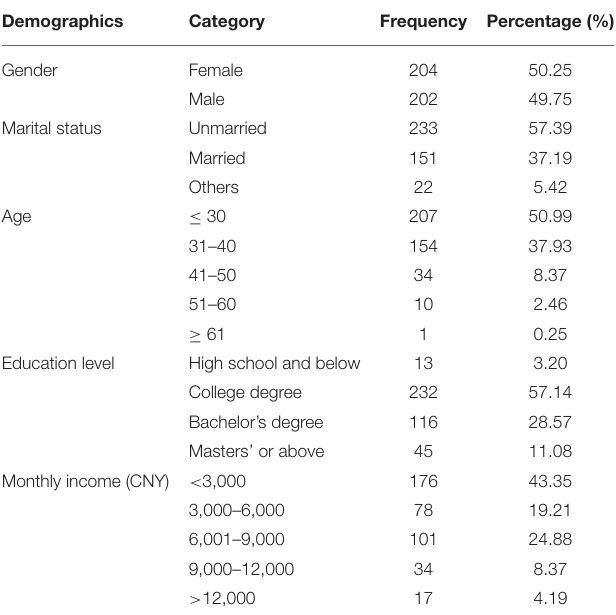
TABLE 1 | Sample demographic profile ( N =